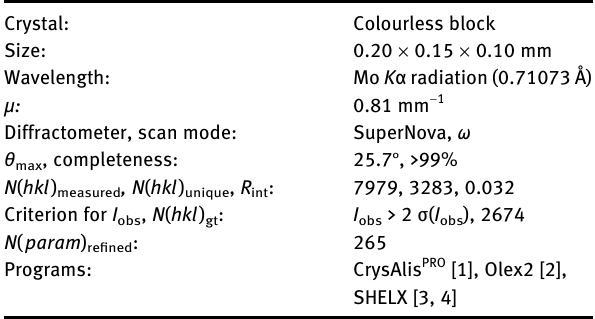
Table  : Data collection and